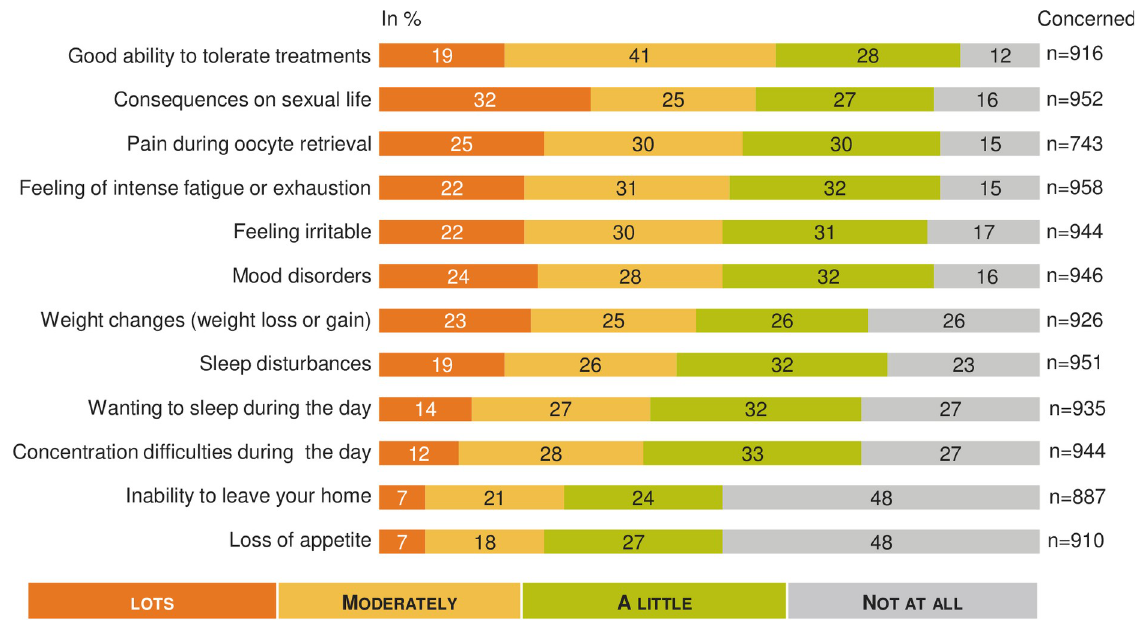
Fig 3. MAR and physical impact: A French national survey. Percentage of answers to the question “Regarding your physical condition in recent months, would you say that you felt each of the following a lot, moderately, a little, not at all?” (n = 916).